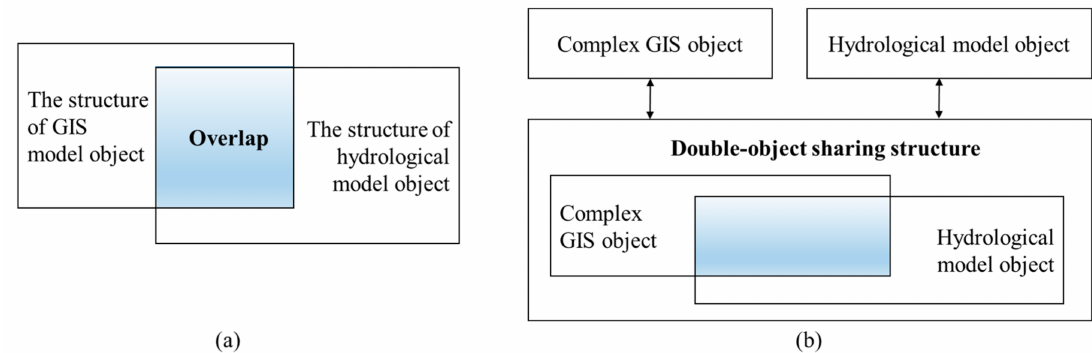
Figure 4. ( a ) The structure overlap of a GIS model object and a hydrological model object. ( b ) A diagram of the double-object sharing